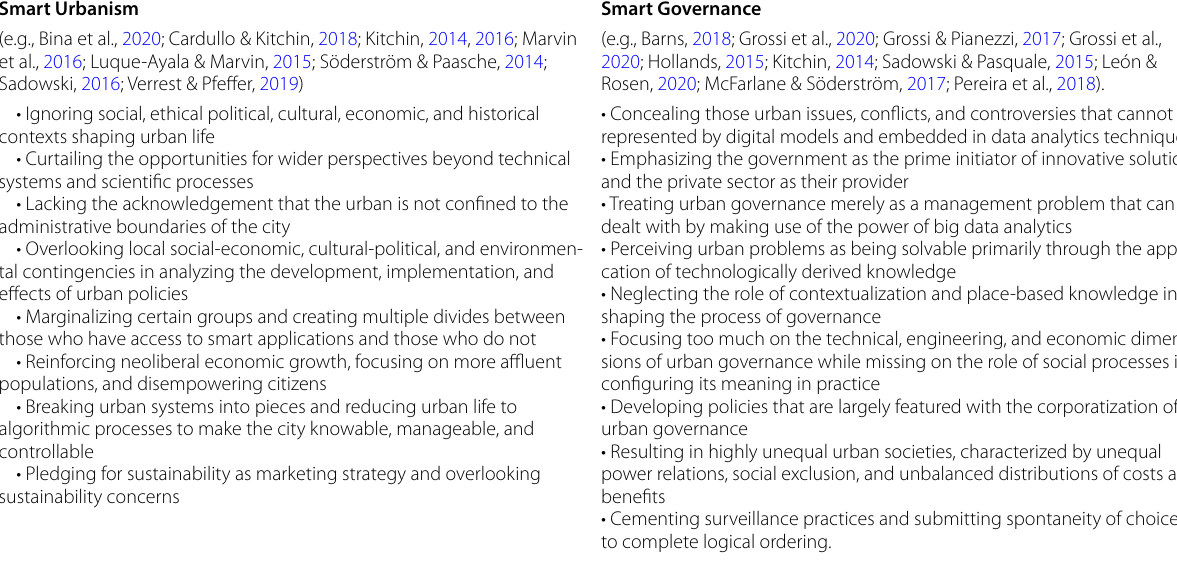
Table 2 The key issues and risks of smart urbanism and smart governance Smart